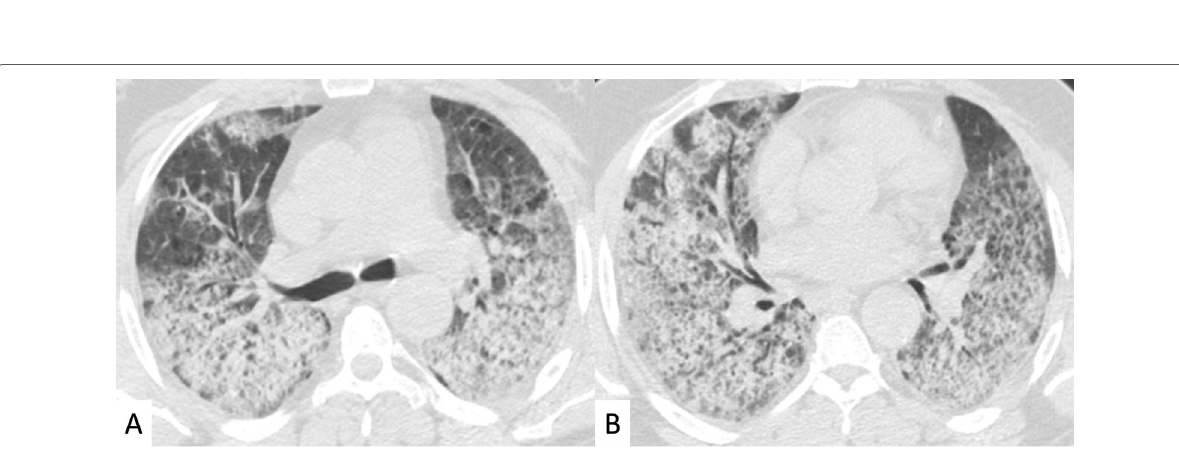
Fig. 22 DAH in a patient with LSD. Images ( A , B ) show diffuse bilateral consolidations and ground-glass